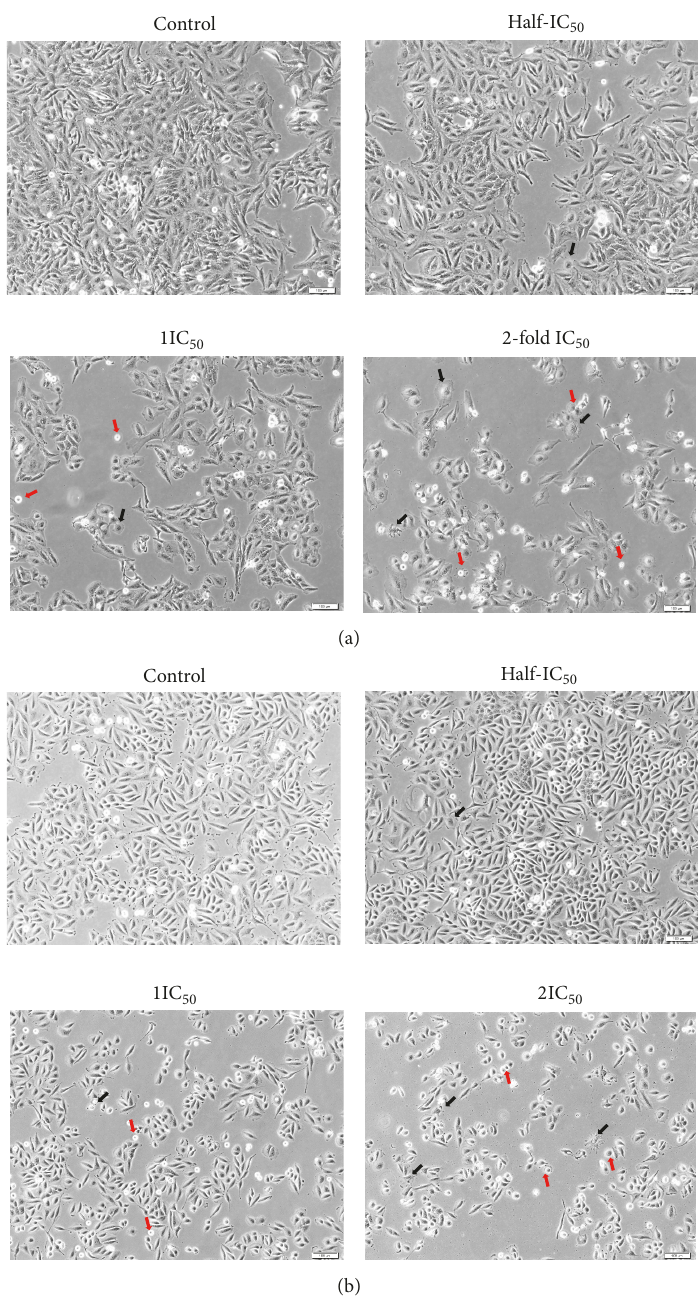
Figure 2: Morphological changes of (a) HeLa and (b) SiHa cells treated with ACE at half IC 50 , IC 50 , and 2-fold IC 50 for 48 h. The cells were evaluated under an Olympus inverted microscope using 10X objective lens (magnification 100X). Morphology of cell changes in star-shape and cell shrinkage were indicated by black and red arrows, respectively. Scale bar: 10 𝜇